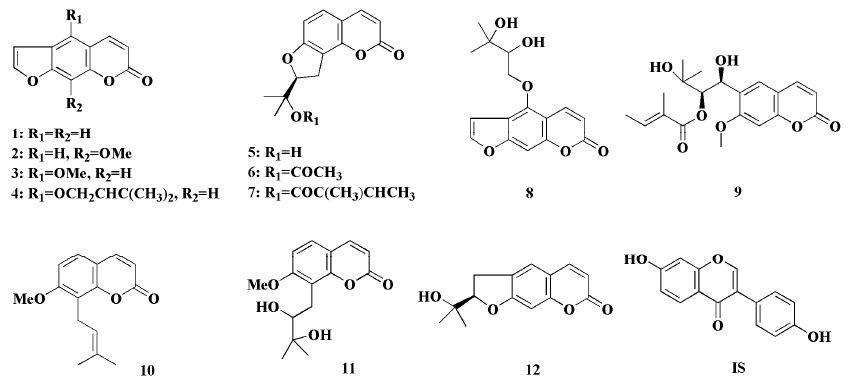
Figure 1. Chemical structures of main coumarins from Angelicae Pubescentis Radix (APR) and the internal standard. ( 1 ) psoralen, ( 2 ) xanthotoxin, ( 3 ) bergapten, ( 4 ) isoimperatorin, ( 5 ) columbianetin, ( 6 ) columbianetin acetate, ( 7 ) columbianadin, ( 8 ) oxypeucedanin hydrate, ( 9 ) angelol B, ( 10 ) osthole, ( 11 ) Meranzin hydrate, ( 12 ) nodakenetin, (internal standard (IS)) daidzein.